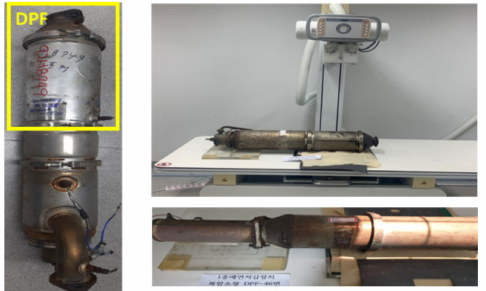
Figure 7. Photographing of the inside of DPF using an X-ray generator.